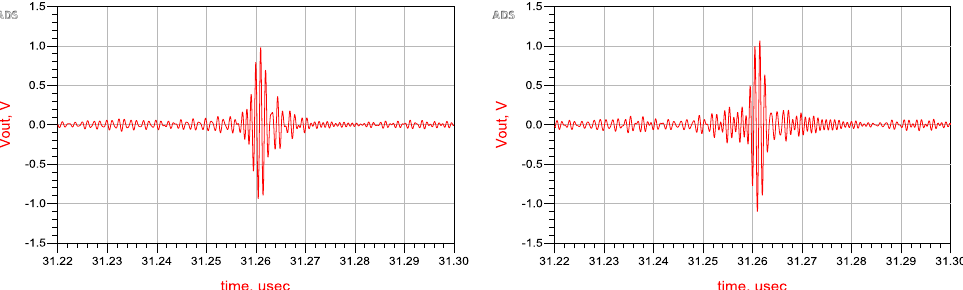
Figure 7. Compressed pulses resulting from the classical CTS system ( left ) and the single-channel system ( right ) with four measured signals. The devices used in both models are ideal.